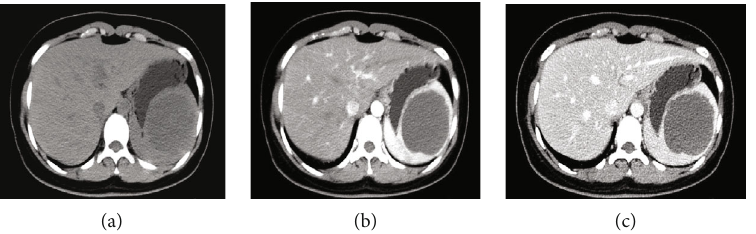
Figure 1: Abdominal CT-enhanced images: (a) shows plain scan; (b) shows arterial phase; and (c) shows venous phase. The upper part of the spleen is about 7-8 cm with slightly low-density shadow.